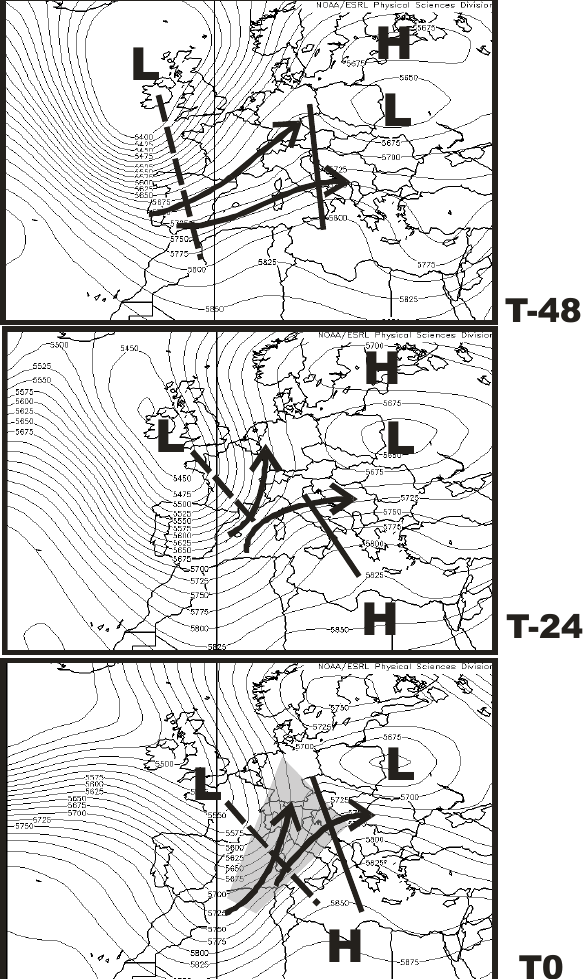
Figure 5. Composite time series at 500hPa for group two consist- ing of two AL events. Heights contours at 100gpm are highlighted (contour interval is 25gpm). Dashed lines indicate troughs while solid lines represent ridges in 500hPa flow. Arrows indicate flow trajectories and shading suggests areas where vertical motion would be expected with flow